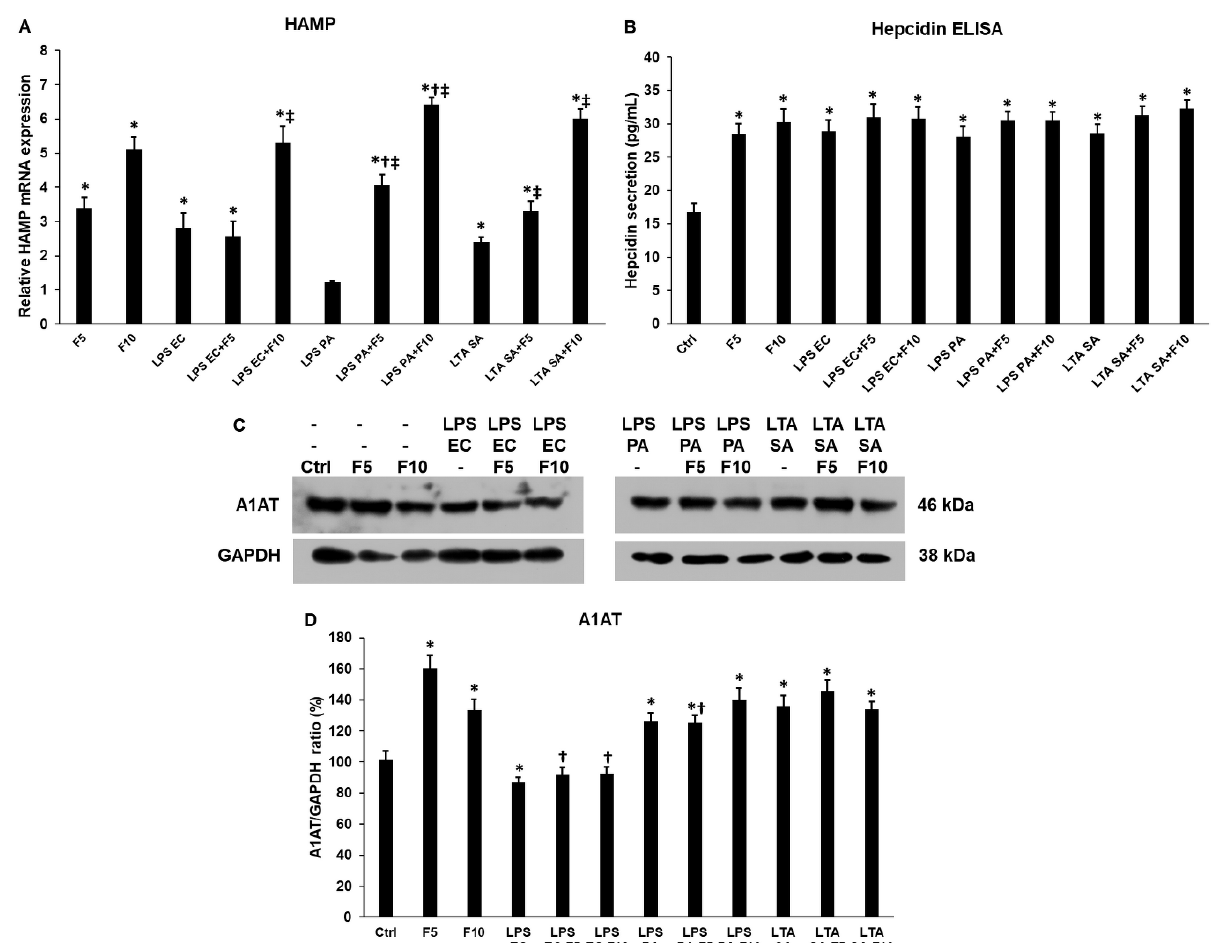
Figure 4. Real time PCR and ELISA measurements of hepcidin expression and Western blot analysis of alpha-1 antitrypsin (A1AT) of E. coli or P. aeruginosa LPS and S. aureus LTA and/or fractalkine-treated THP-1 cells. Real-time PCR was carried out with SYBR Green protocol and β -actin housekeeping gene was used as internal control for the normalization of the reaction. The relative expression of untreated control cells was regarded as 1. Secreted hepcidin concentration of the